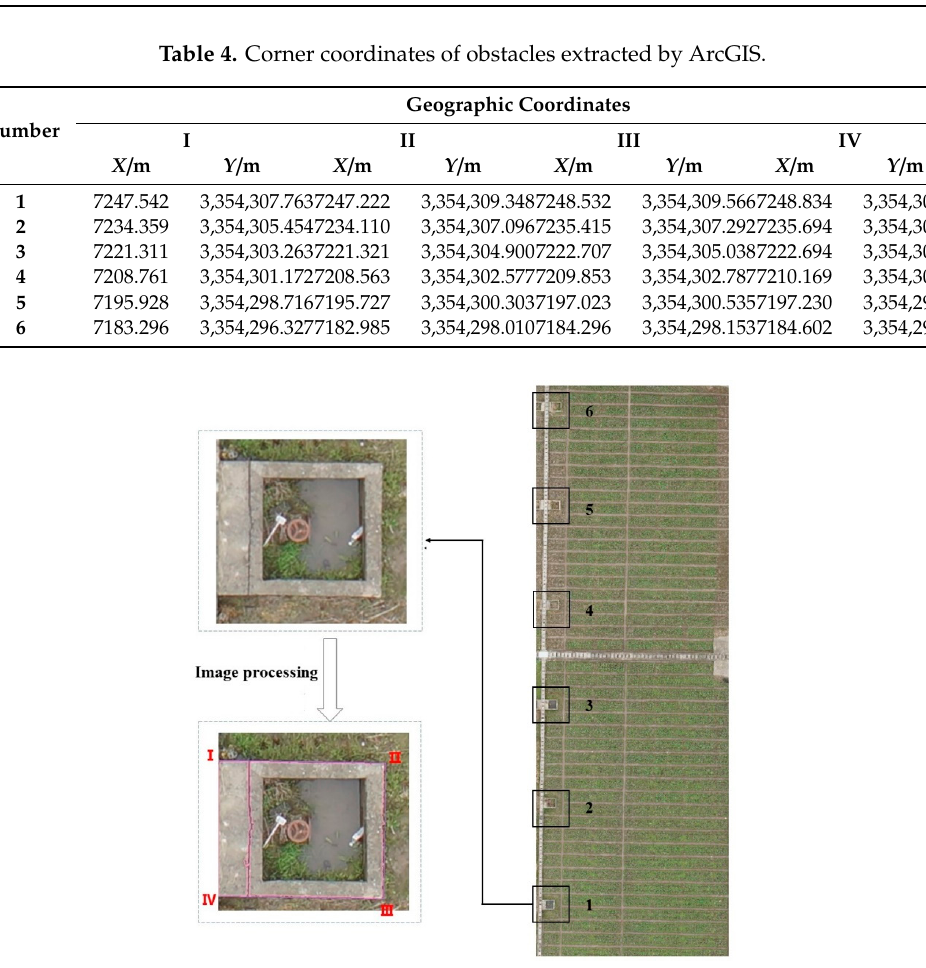
Figure 3. Obstacle number and corner sequence.